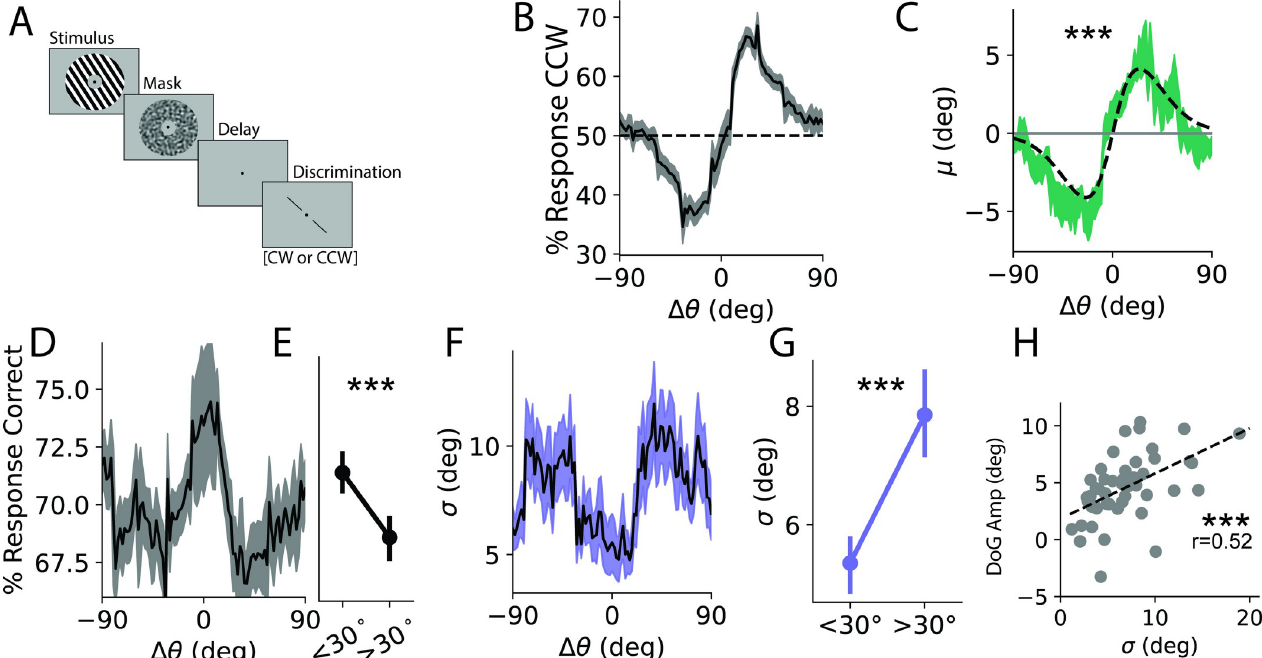
Fig 1. Caption behavior. (A) Task schematic. An orientated stimulus is followed by a probe bar that is rotated < 15˚ from the stimulus. Participants judged whether the bar was CW or CCW relative to the stimulus in a binary discrimination task. (B) Response bias: % of responses that were CCW as a function of Δ θ = θ n − 1 − θ n ( ± SEM across participants). (C) Behavioral bias, green: average model-estimated bias as a function of Δ θ ( ± SEM across participants); gray: average DoG fit to raw participant responses sorted by Δ θ ( ± 1SEM across participants). (D) Response accuracy as a function of Δ θ . (E) Responses are significantly more accurate for | Δ θ | < 30˚. (F) Behavioral σ as a function of Δ θ . (G) Behavioral variance is significantly less for | Δ θ | < 30˚. Note that in computing variance, we “flip” the sign of errors following CCW inducing trials to avoid conflating bias with variance (see Methods). (H) Bias is positively correlated with variance across participants. ��� , p < 0.001. Data and code supporting this figure found here: https://osf.io/e5xw8/?view_only= e7c1da85aa684cc8830aec8d74afdcb4. CCW, counterclockwise; CW,